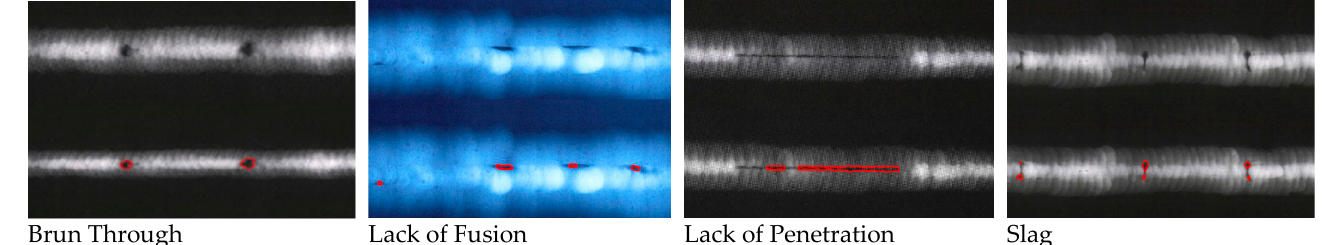
Figure 1. A combination of radiographic and image processing techniques for welding defect detection conducted by Faramarzi et al. [18].